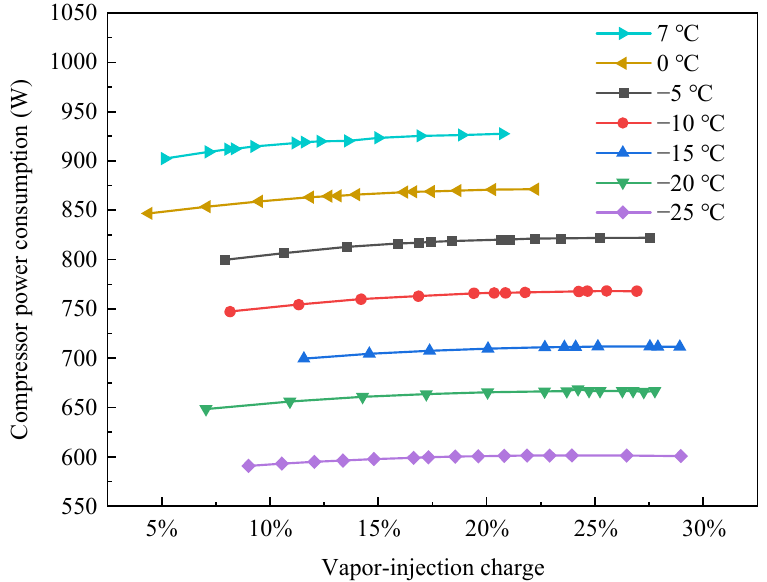
Figure 7. Influence of vapor-injection charge on the compressor power consumption of the HHE– ASHPD system.